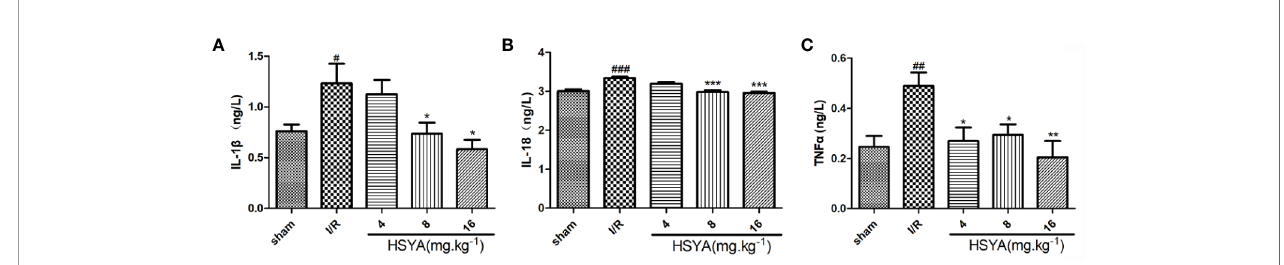
FIGURE 3 | Hydroxysaf fl or yellow A (HSYA) inhibits the secretion of in fl ammatory factors. (A) Serum TNF- a level was analyzed by ELISA 24 h post-reperfusion (n=6 per group). (B) Serum interleukin (IL)-1 b level was analyzed by ELISA 24 h post-reperfusion (n=6 per group). (C) Serum IL-18 level was analyzed by ELISA 24 h post- reperfusion (n=6 per group). Data are presented as means ± SEM. # P < 0.05, ## P < 0.01, ### P < 0.001 vs . the sham group, *P <0.05, **P < 0.01, ***P < 0.001 vs . the ischemia/reperfusion (I/R) group.